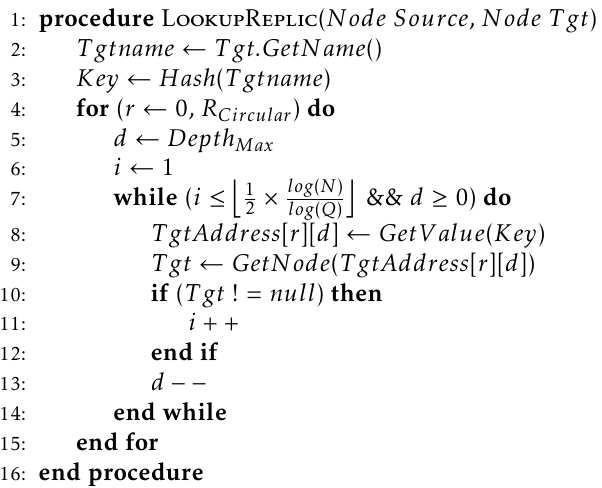
Algorithm 4 Lookup Algorithme in Replication Context